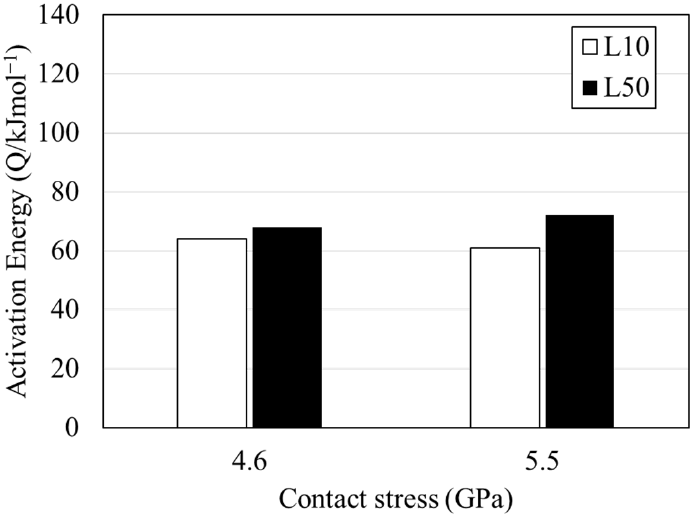
Figure 9. Activation energies of rolling contact fatigue life originated from microstructural alterations at different applied loads (adapted from [88] ) .